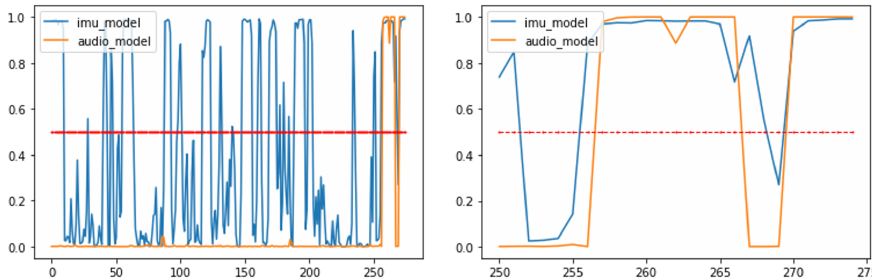
Figure 14. Plots displaying outputs of developed DL models during 275 s of 1st SaR scenario ( left ). Red line denotes threshold value (i.e., 0.5) for classifying an audio signal as “bark” and IMU signal as “stand”. The final 25 s of this scenario are displayed on ( right )